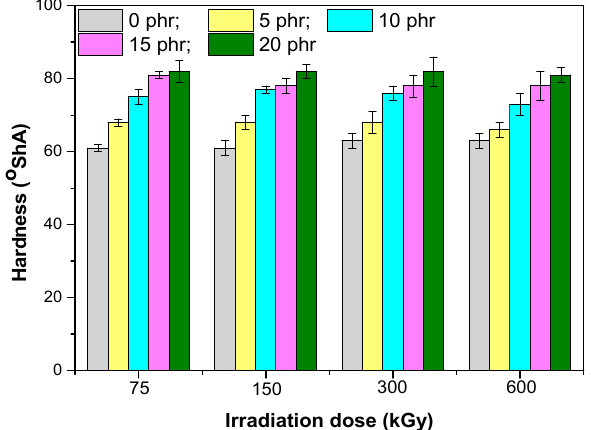
Figure 5. Hardness versus electron beam irradiation dose and the amount of hemp fibers.